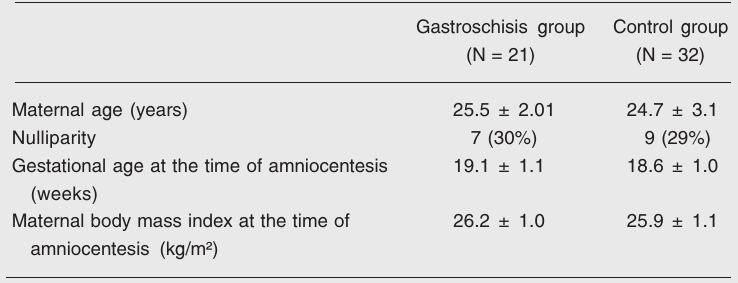
Table 1. Demographic characteristics of the study and control